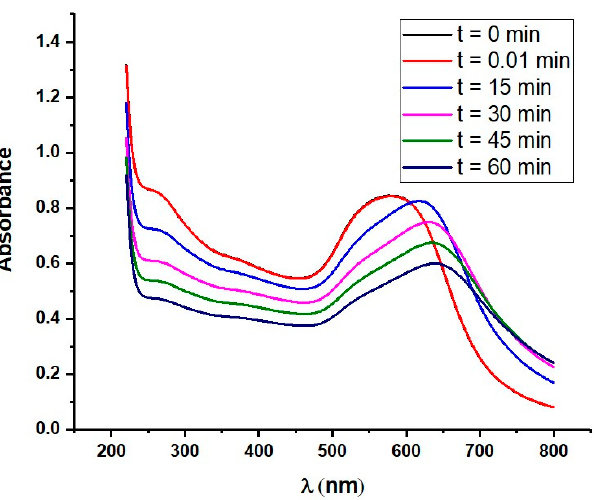
Figure 7. UV-vis absorption spectra of β -casein and MCH-conjugated AuNPs treated with 10 nM trypsin at different time points. Note that at time 0 and 0.01 min, the spectra are almost identical. Trypsin at concentrations ranging from 0.1 to 10 nM was used in the study to estimate we have plotted the changes in relative values of absorbance measured at around 640 nm after 15 min of trypsin exposure against the trypsin concentration (Figure 8a). As in the case of the analysis of trypsin activity via the TSM method, we were able to use an inverse Michaelis–Menten (MM) model expressed by Equation (3) to analyze the obtained cali- bration curve for trypsin activity in volume. Figure 8. Calibration plots of colorimetric assay. ( a ) Changes in relative values of absorbance after β -casein and MCH functionalized gold nanoparticles (AuNPs/MCH- β -casein) exposure to trypsin (A 0 —exposure time 0 min, A 15 —exposure time 15 min.) vs. concentration of trypsin (C TRY ). Symbols are experimental data, and the red line is the best fit of Equation (3). ( b ) Linear part of the calibration curve for calculation of the limit of detection (LOD). Values are means ± SD ( n = 3). Red line is the linear regression fit. The fitting of calibration plots with the MM model yielded v max = 14.98 ± 0.81% and K M = 0.56 ± 0.10 nM. As was already mentioned, in the inverse MM model, the roles of the enzyme and substrate are swapped, and the concentration of the enzyme is changed while the substrate is presented in excess.